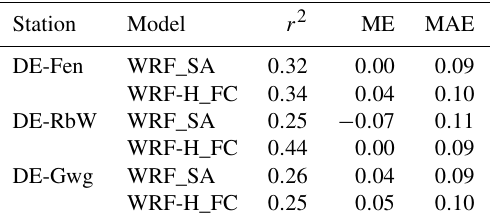
Table 5. Performance measures for evapotranspiration (mmh − 1 ) with simulations vs. lysimeter observations for June to Octo- ber 2016.